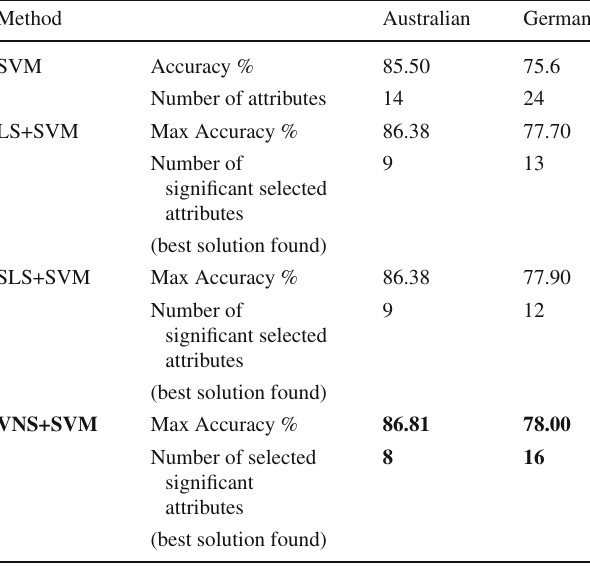
Table 9 SVM .vs. LS+SVM .vs. SLS+SVM .vs. VNS+SVM